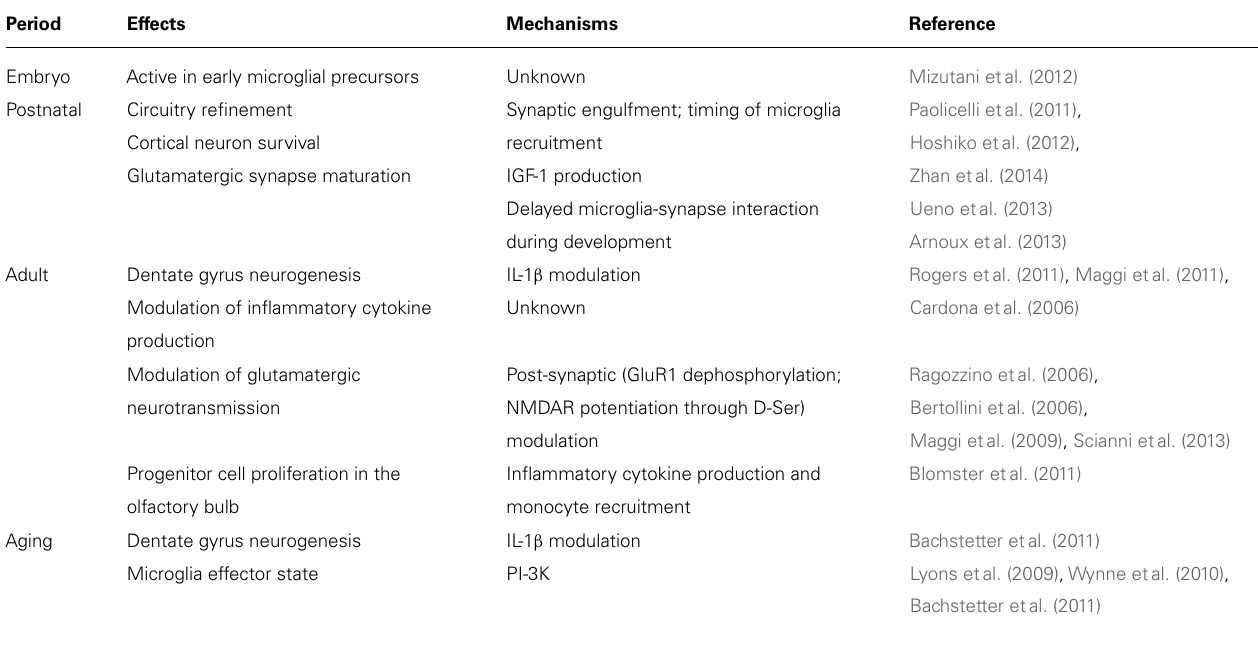
Table 1 | Documented effects in (ex) vivo of CX3CL1/CX3CR1 signaling in lifespan.